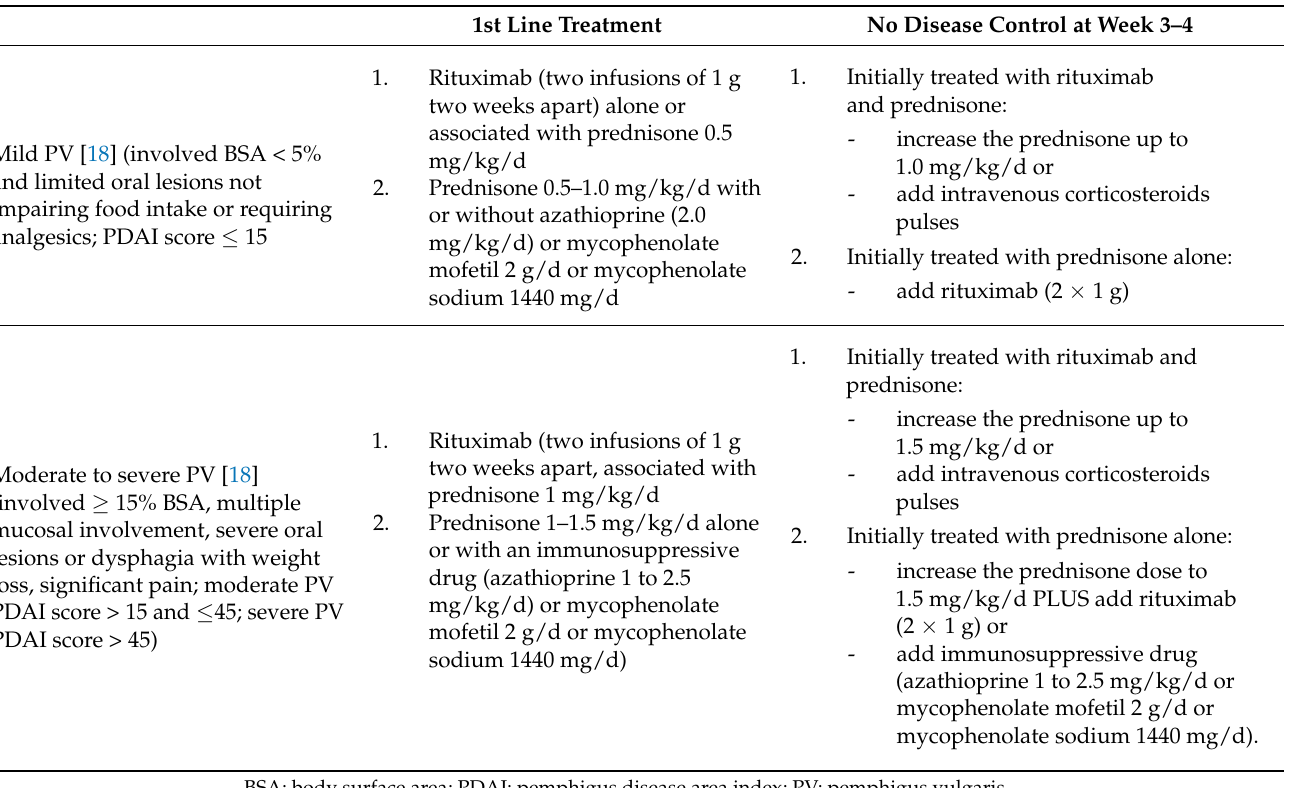
Table 1. Treatment of